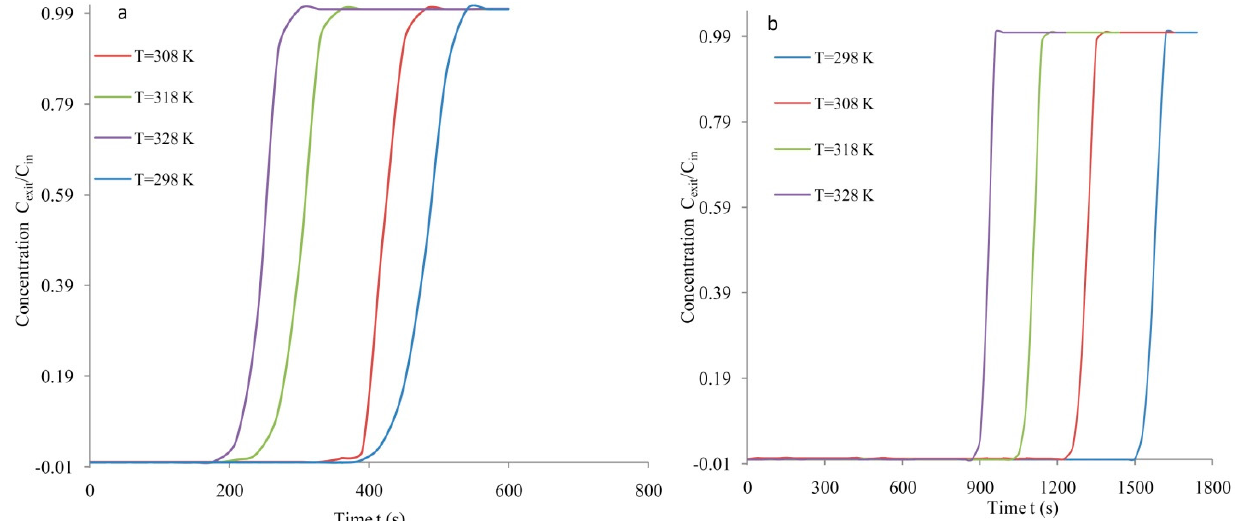
Figure 7. Adsorption response at various temperatures at F = 4 lpm, C o = 5%: ( a ) MS-3Å, and ( b ) AC-SY.